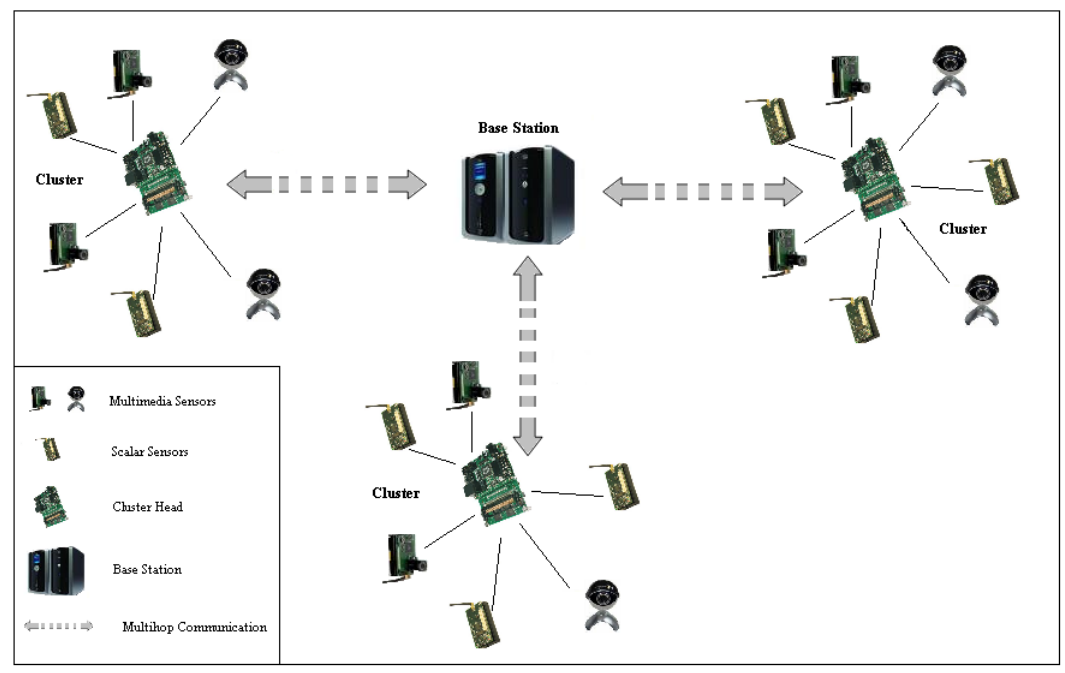
Figure 1. Single-tier Clustered